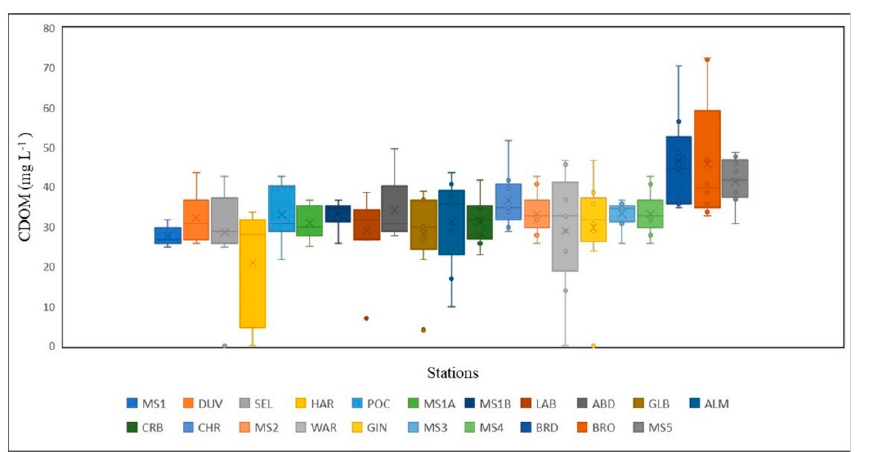
Figure 7. Box and whisker plot illustrating the results for CDOM. The three box and whiskers to the right are the Triblets Beards (BRD), Broad (BRO), and MS5 which are similar to each other and different from all other stations.